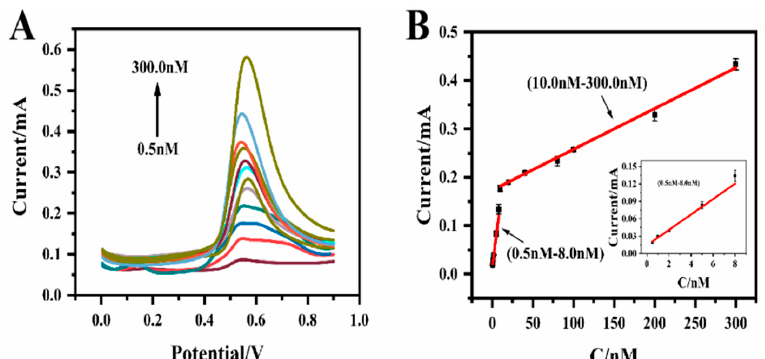
Figure 7. ( A ) DPV responses of BPA in blank pH 7.0 PBS after the recognition of different concen- trations of BPA; ( B ) Calibration curves for BPA in the concentration ranges of 0.5 nM to 8.0 nM and 10.0 nM to 300.0 nM. The inset plot represented the calibration curve in the concentration ranges of 0.5 nM to 8.0 nM.